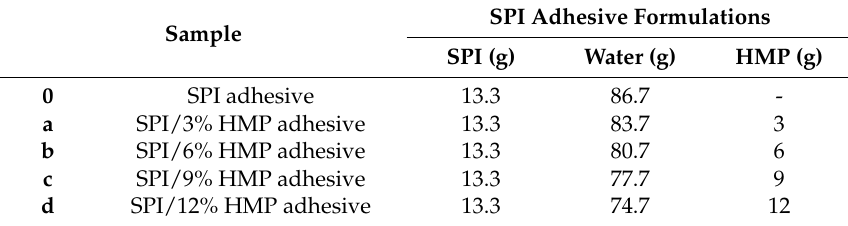
Table 2. Various soy protein isolate (SPI) adhesive